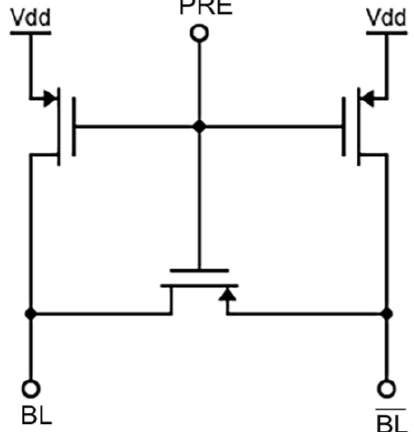
Figure 2. Sample Precharge circuit.